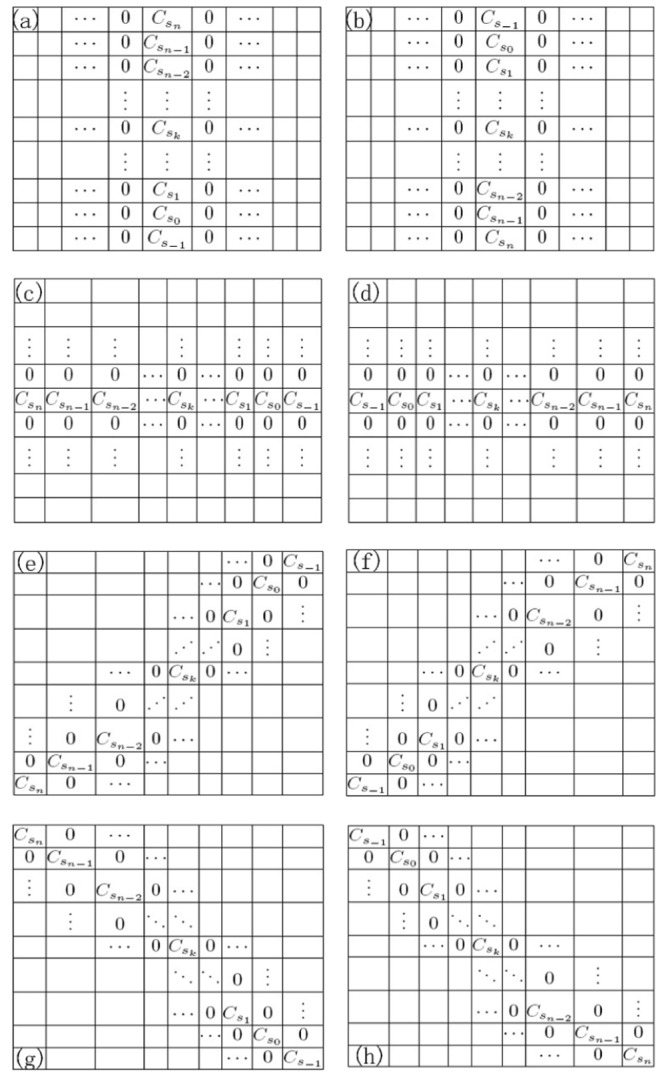
Fractional differential operator VOFCD for the eight directions.(a) W
1(negative x–axis), (b) W
2(positive x–axis), (c) W
3(negative y–axis), (d) W
4 (positive y–axis), (e) W
5(left downward diagonal), (f) W
6 (right upward diagonal), (g) W
7(left upward diagonal), (h) W
8 (right downward diagonal).